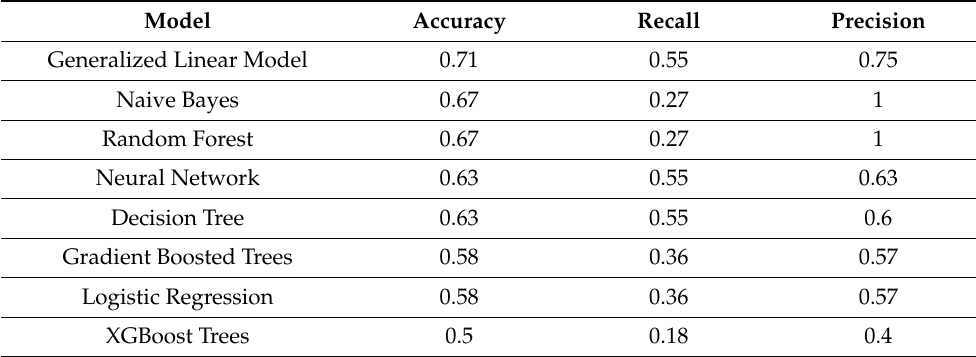
Table 2. Scoring metrics of machine learning algorithms.